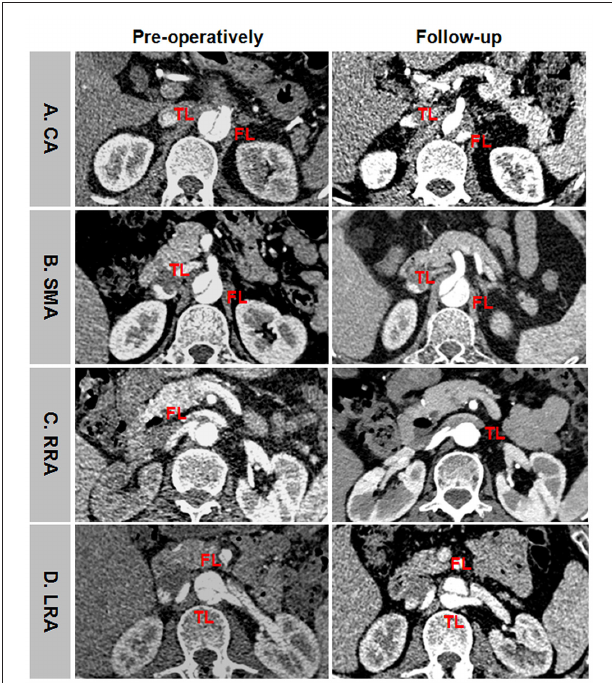
FIGURE 8 | An example of positive branch remodeling after TEVAR. (A) CA was perfused by FL at baseline and by TL during follow-up. (B) SMA was perfused by BL at baseline and by TL during follow-up. (C) RRA was supported by FL at baseline and by TL during follow-up. (D) LRA was supported by BL at baseline and by TL during follow-up. TEVAR, thoracic endovascular aortic repair; FL, false lumen; TL, true lumen; BL, bilateral lumen; CA, celiac artery; SMA, superior mesenteric artery; RRA, right renal artery; LRA, left renal artery.